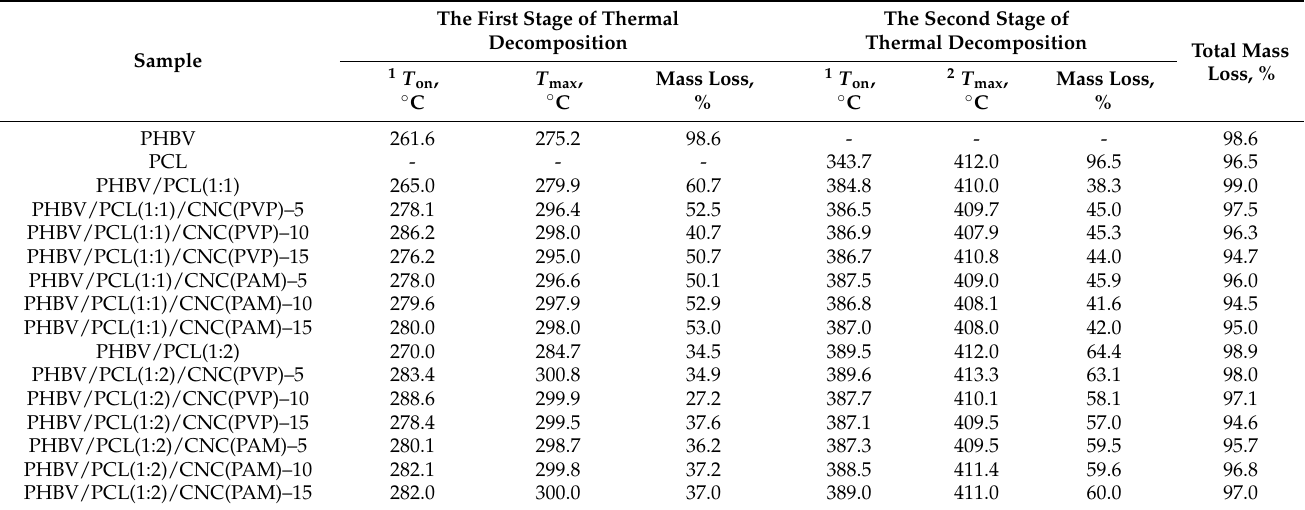
Table 3. Thermal stability of the PHBV/PCL mixtures and PHBV/PCL/CNC